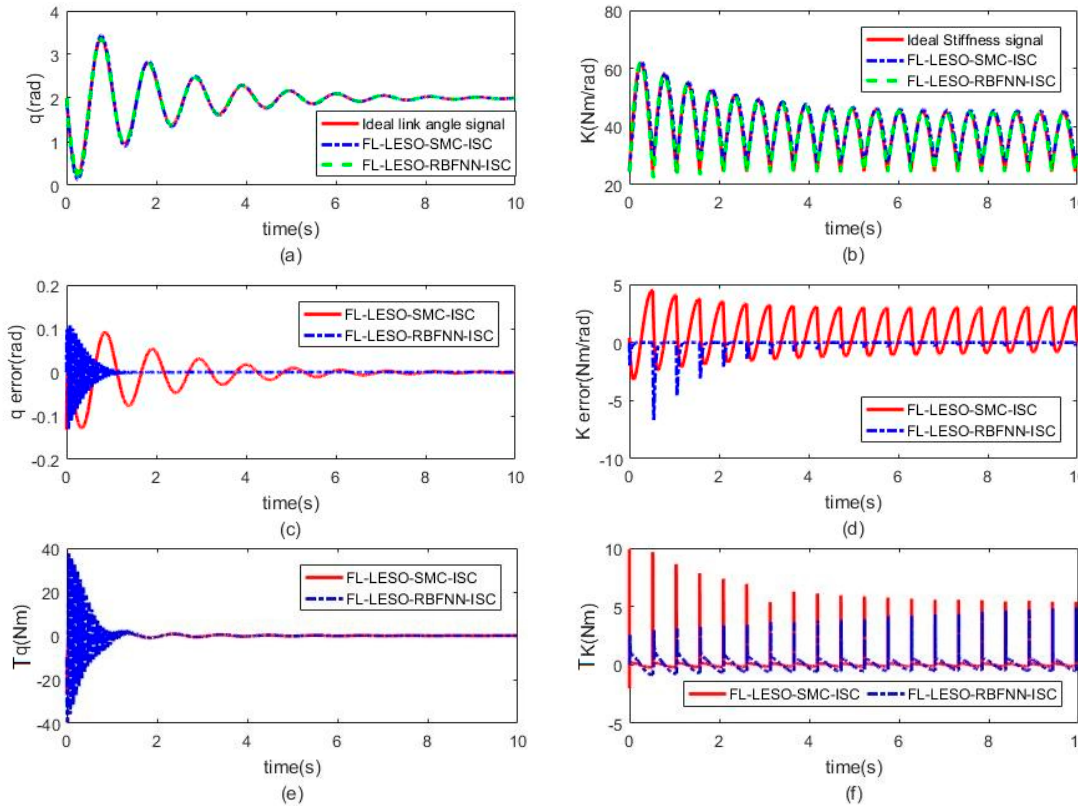
Figure 5. Simulation results. ( a ) VSJ angle tracking output response of two control algorithm. ( b ) VSJ stiffness tracking output response of two control algorithm. ( c ) VSJ angle tracking error VSJ angle tracking error of two control algorithm. ( d ) VSJ stiffness tracking error VSJ angle tracking error of two control algorithm. ( e ) VSJ angle tracking control torque of two control algorithm. ( f ) VSJ stiffness